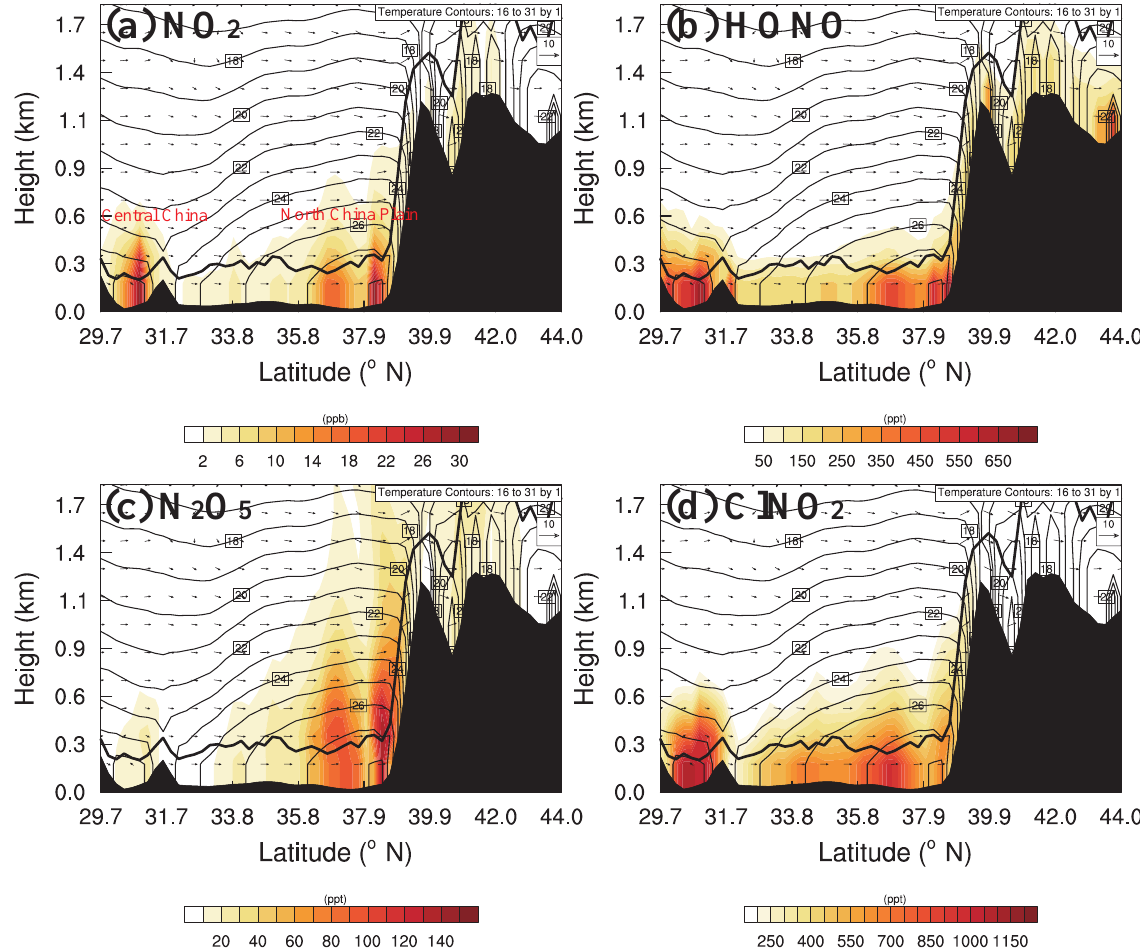
Figure 3. Vertical distributions of (a) NO 2 (ppb), (b) HONO, (c) N 2 O 5 , and (d) ClNO 2 (ppt) during nighttime (18:00–06:00LT) in the domain intercepting northern China and central China. Vectors present the average v – w wind components (ms − 1 ) , the dash lines the temperature ( ◦ C), and the bold black line the simulated planetary boundary layer height during the